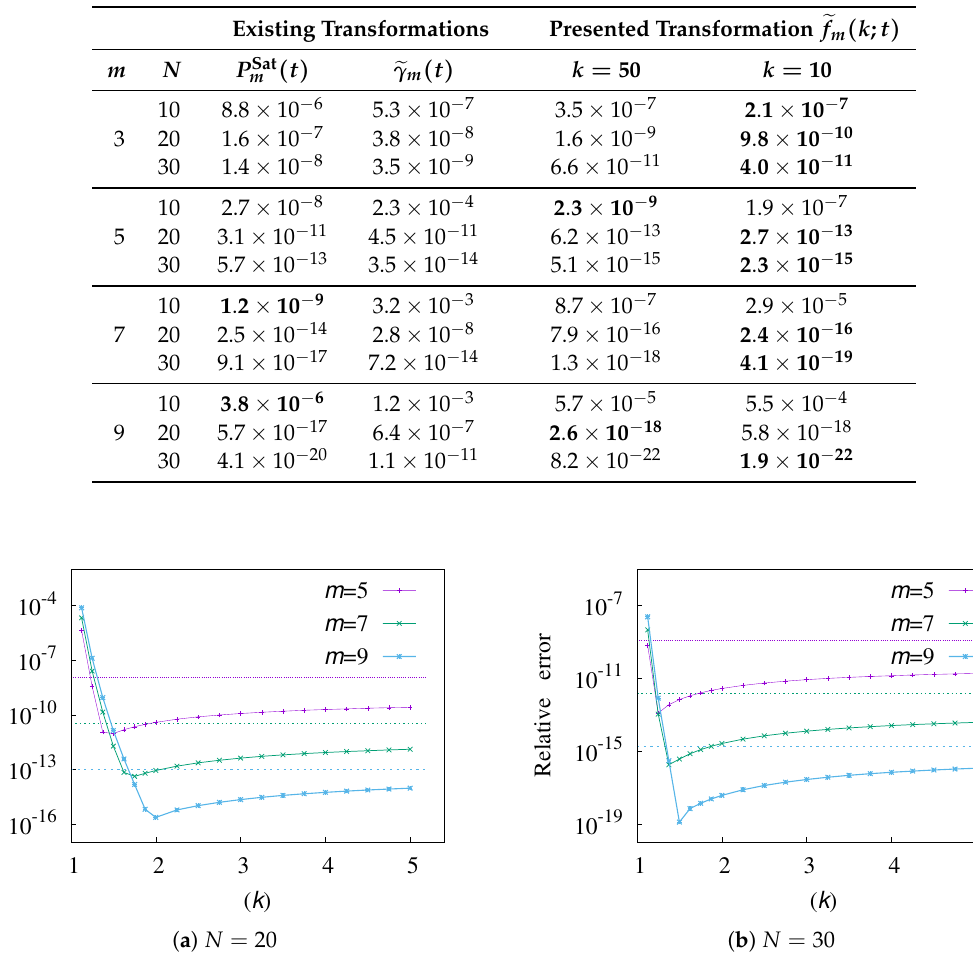
Table 3. Relative errors of the N -point Gauss-Legendre quadrature rule corresponding to the existing transformations P Sat m ( t ) , (cid:101) γ m ( t ) and the presented transformation (cid:101) f m ( k ; t ) for the end-point logarithmic singular integral J φ ( ξ 0 ) , with ξ 0 = 1, in Example 2.